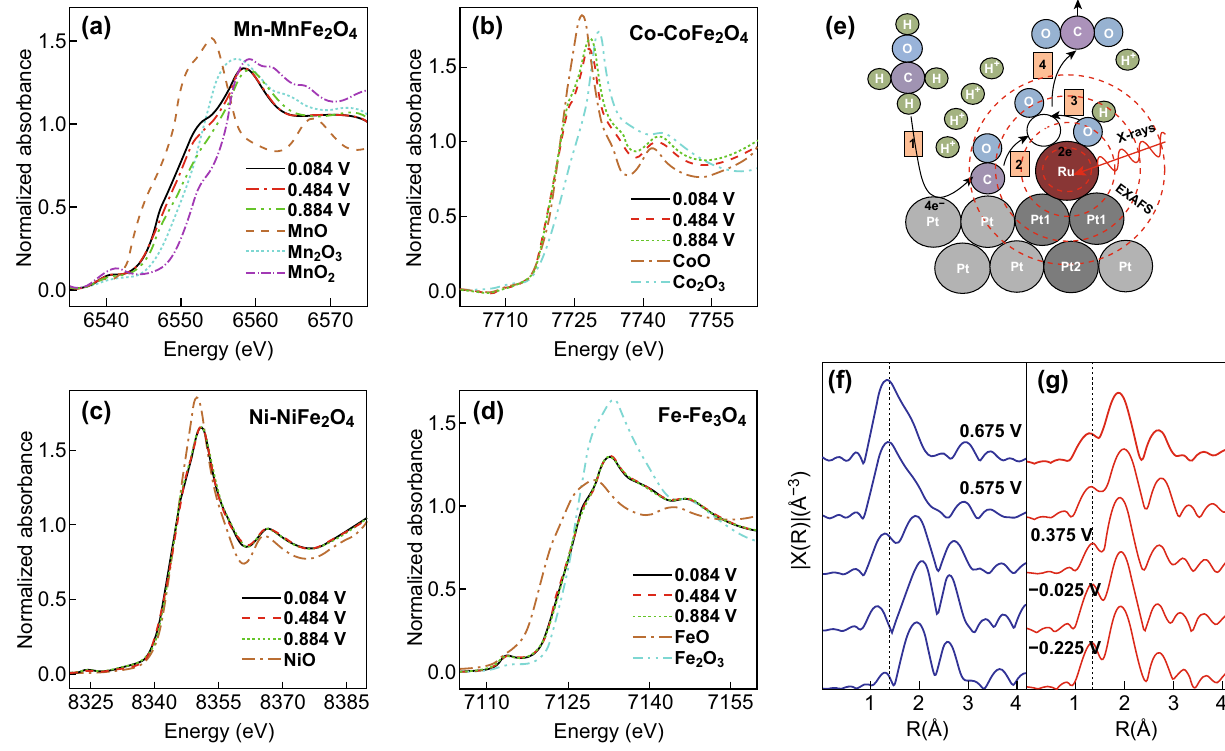
Fig. 8 K-edge XANES spectra of a Mn in MnFe 2 O 4 , b Co in CoFe 2 O 4 , c Ni in NiFe 2 O 4 , and d Fe in Fe 3 O 4 under various applied potentials. Reprinted with permission from Ref. [37]. e Schematic of the surface reaction of the Ru atoms. R-space graphs as a function of applied potential f without (blue) and g with (red) CH 3 OH. Dotted line placed at ca. 1.4 Å signifying a reference point for the oxygen peaks. Reprinted with per- mission from Ref. [82]. (Color figure